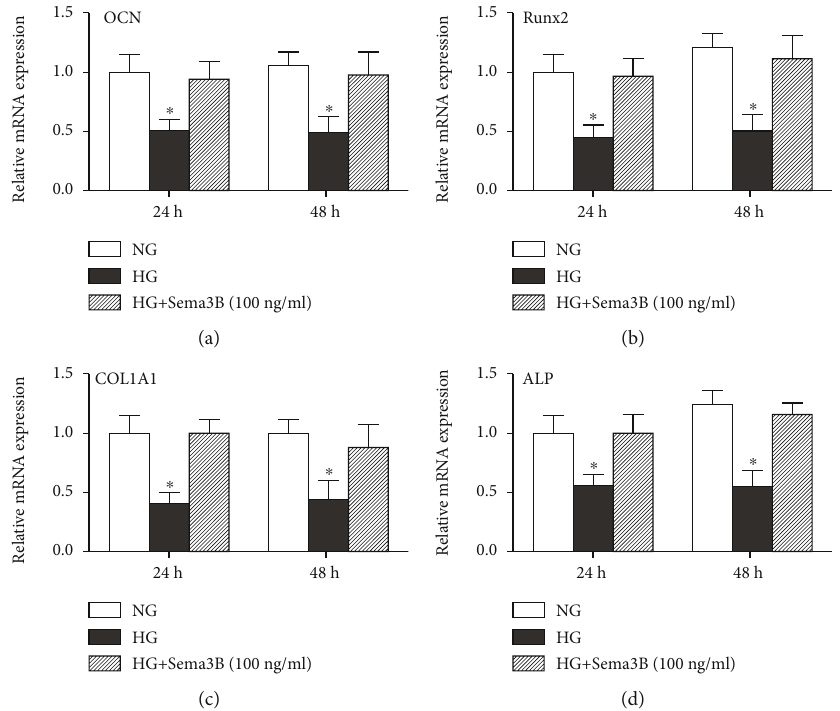
Figure 4: E ff ects of Sema3B on osteogenic markers under HG treatment. OCN (a), Runx2 (b), COL1A1 (c), and ALP (d) mRNA expression levels in BMSCs were measured by real-time PCR at each time point. Real-time PCR results are expressed as the mean ± SEM ( n = 3 ). ∗ P < 0 : 05 compared to the other samples.